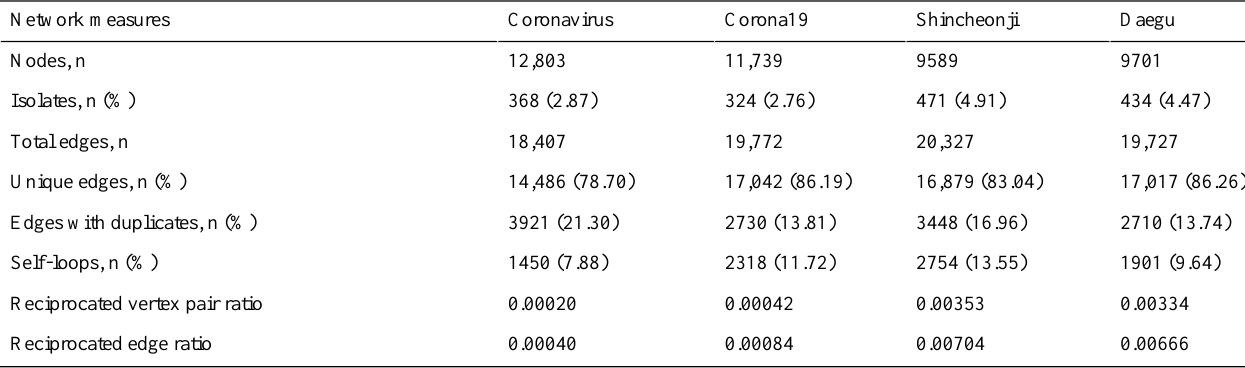
Table 2 summarizes the overall attributes of each network. When a Twitter network is drawn in concentric form, the step required